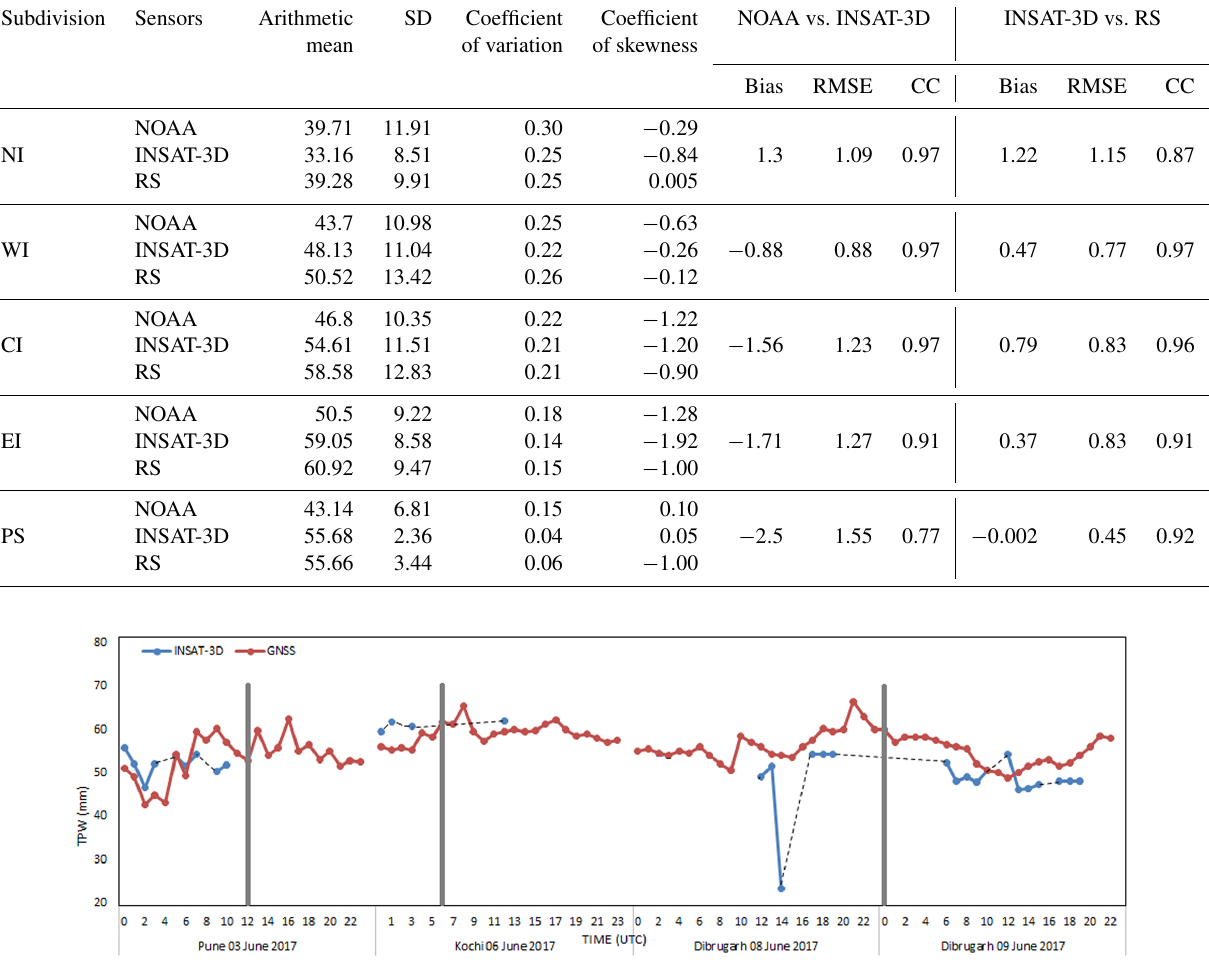
Table 3. Statistics of INSAT-3D-derived-, RS-, and NOAA-observed TPW subdivision scales of India. Subdivision